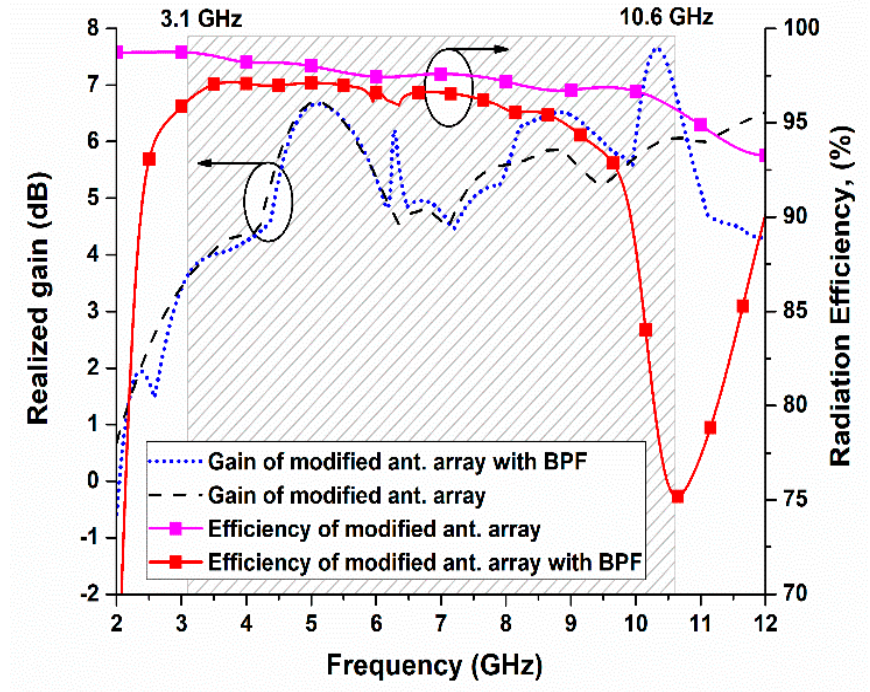
Figure 12. Simulated realized gain and radiation efficiency of the modified UWB antenna array with and without BPF.